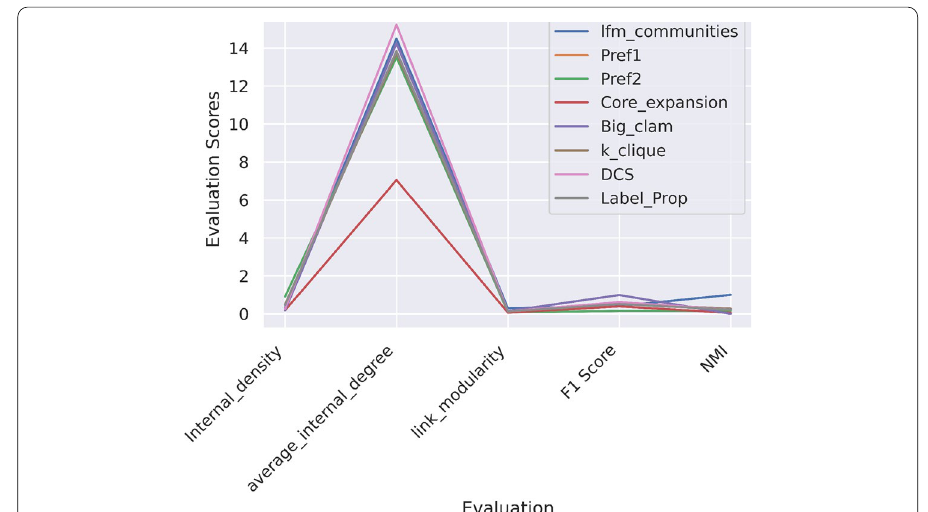
Fig. 15 Different measures such as internal degree, link modularity, F1 score, NMI are plotted for undirected weighted network of UK faculty using community detection algorithms (Csardi and Nepusz 2006). We have used Core-expansion, Big-clam, K-clique, DCS, label-propagation and LFM to show further